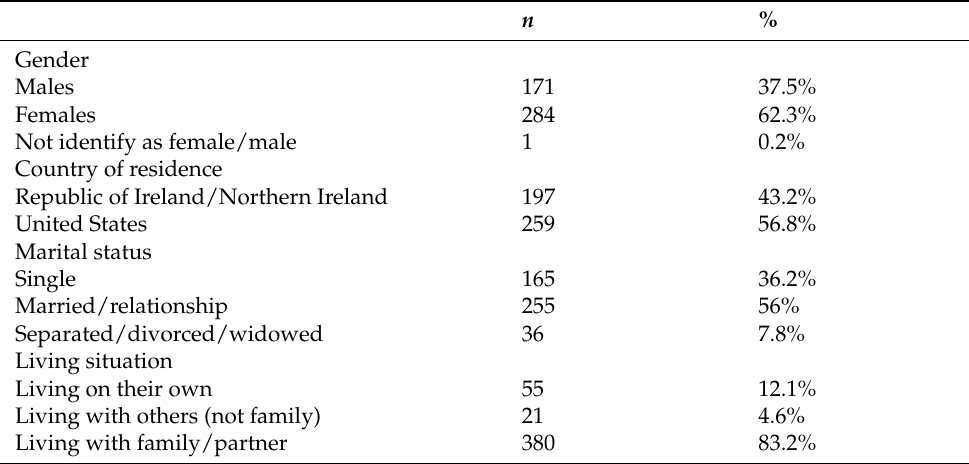
Figure 1. Representation of the hypothesized mediation model. Traumatic distress of COVID-19 is expected to influence depression levels, while resilience, hope and anxiety are expected to mediate this influence.